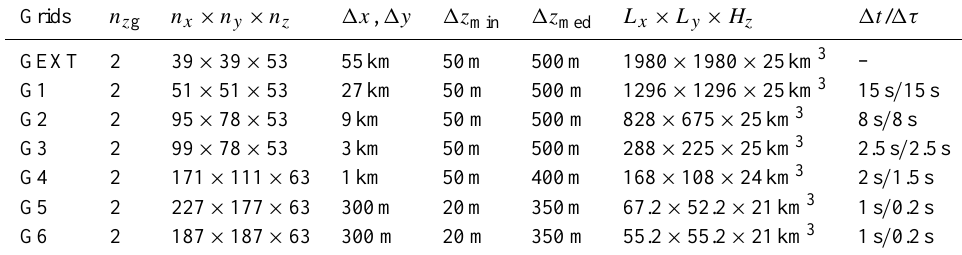
Table 2. Structure of the one-way nested numerical grids. Given the number of grid points n x , n y and n z , the physical domain size can